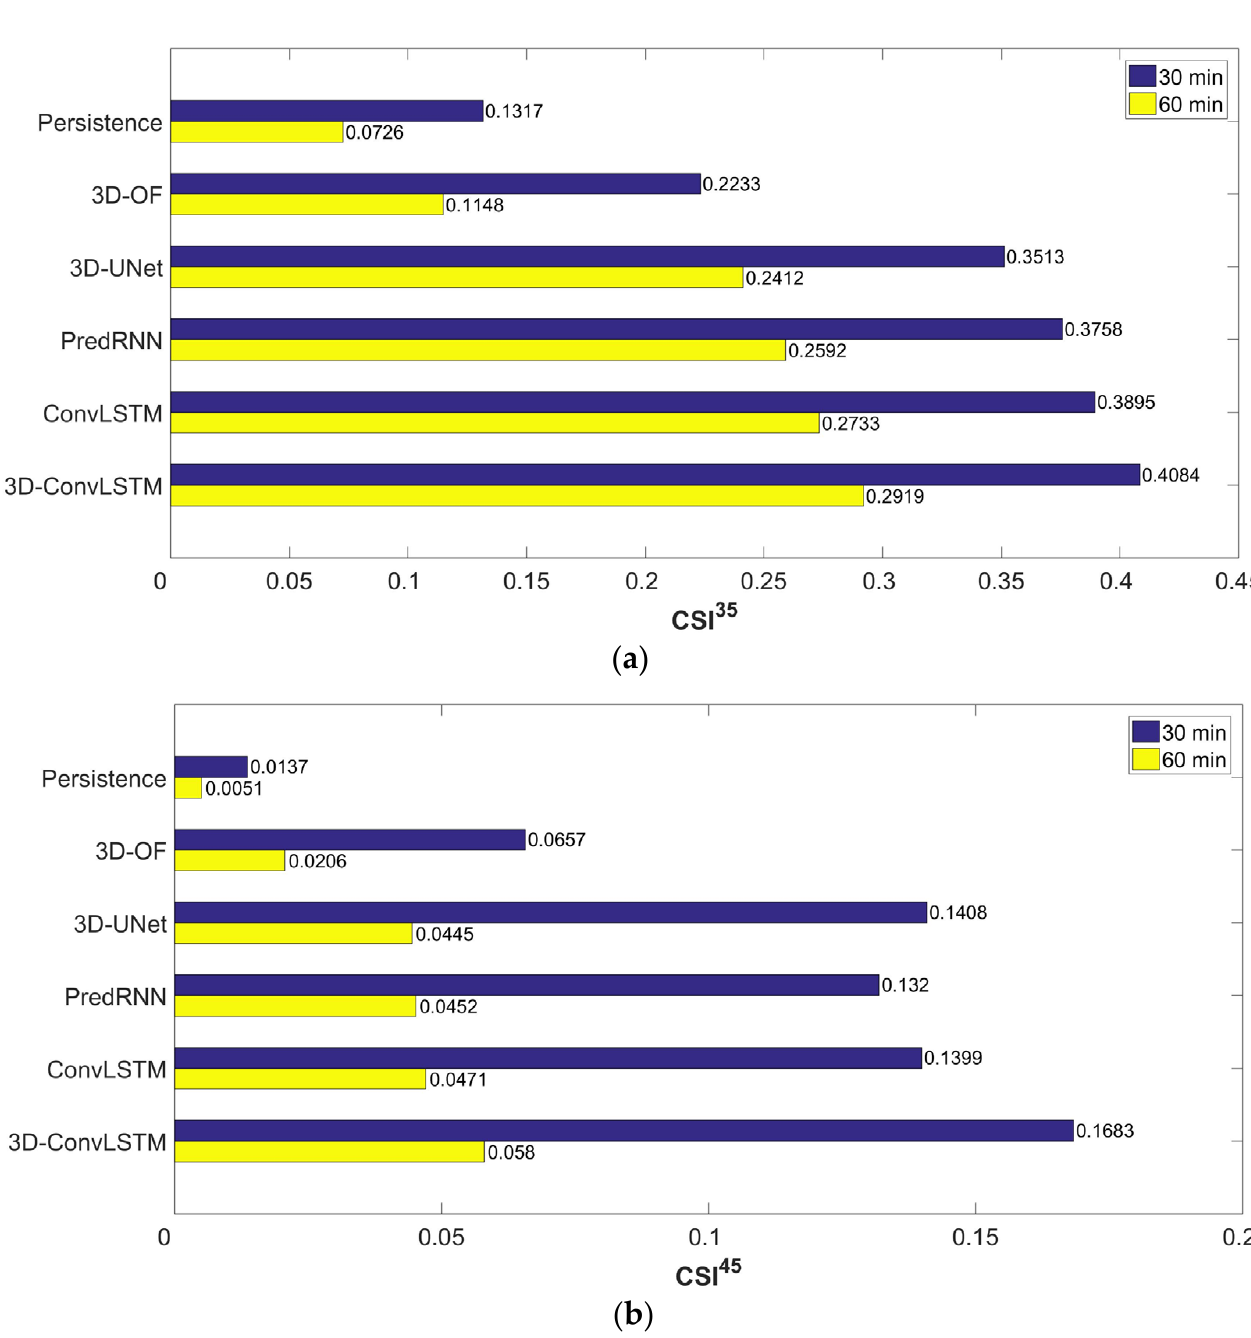
Figure 4. ( a ) CSI scores for 35 dBZ threshold of 30 min (blue) and 60 min (yellow) nowcasts obtained by different models. ( b ) CSI scores for 45 dBZ threshold of 30 and 60 min nowcasts obtained by different models.